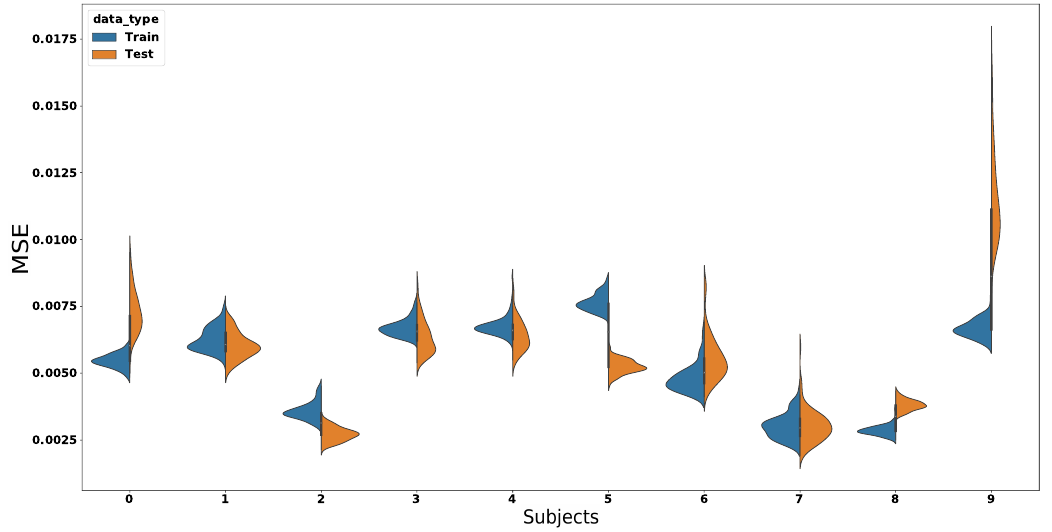
Figure 9. This figure illustrates the MSE for every subject in the experiments. Each number in the x -axis from 1 to 7 represents a subject in the experiments. Violin plots 7, 8, and 9 were of two 15 degree incline walks and to all subjects’ signals combined, respectively. Every violin plot consists of two distributions (i.e., Train—blue and Test—orange ) and the mean of the MSE. The distributions illustrate the MSE variance over 100 runs. This figure shows that the ED-FNN managed to accurately predict the gait cycle over several